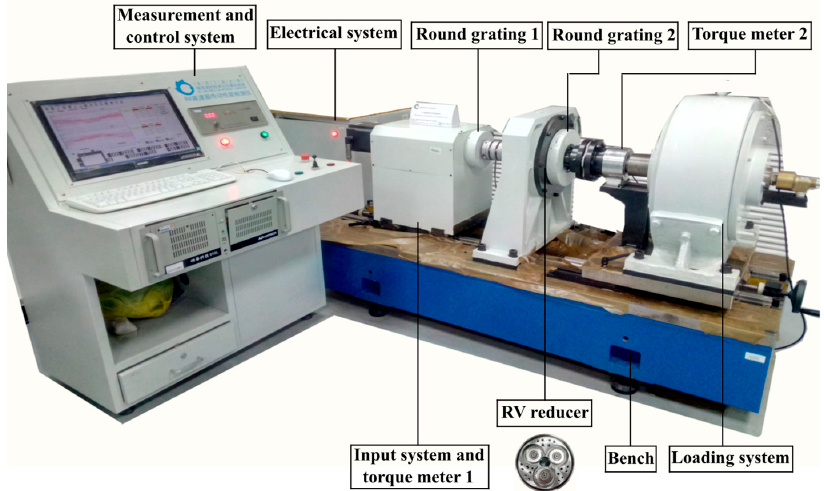
Figure 8. Transmission performance tester of RV reducer.